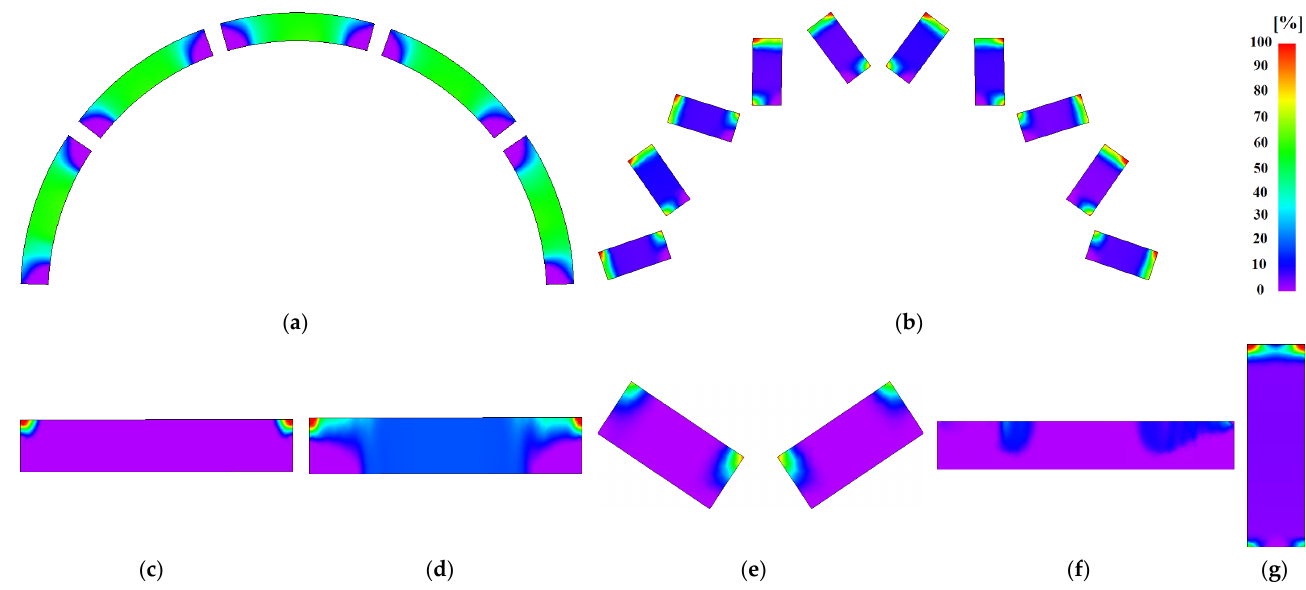
Figure 5. Contour plots of magnet remanence ratio values for the eight baseline PM machines ( i d = -5 p.u., i q = 0 p.u.): ( a ) FSCW-SPM; ( b ) FSCW-IPM; ( c ) DW-IPM (Flat 1); ( d ) DW-IPM (Flat 2); ( e ) DW-IPM (V shape); ( f ) FI-IPM; ( g ) DW-IPM (spoke).